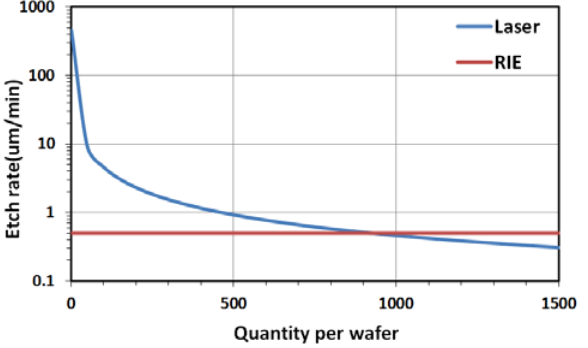
Figure 6 . Etch rate comparison.